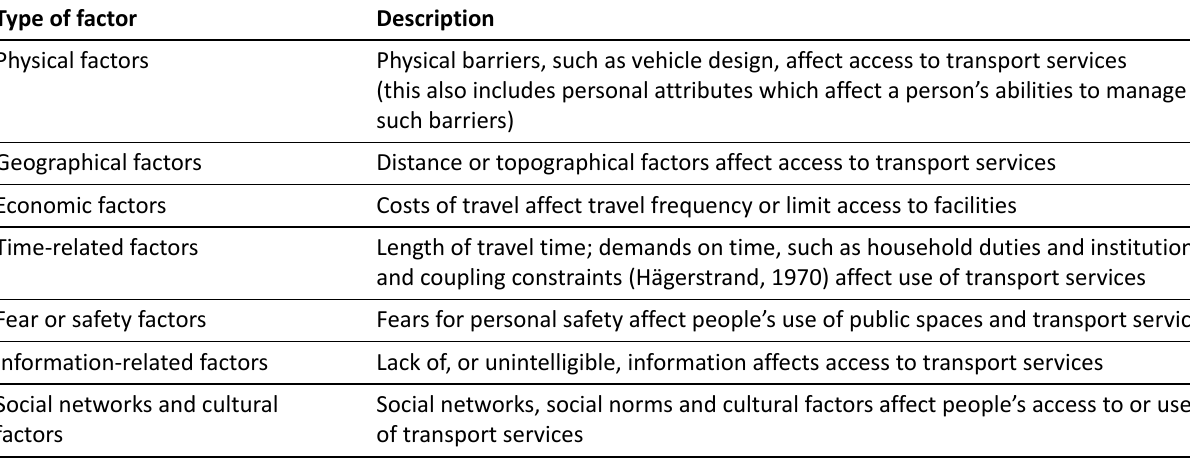
Table 1. List of final provisional codes (adapted from Church et al., 2000). Type of